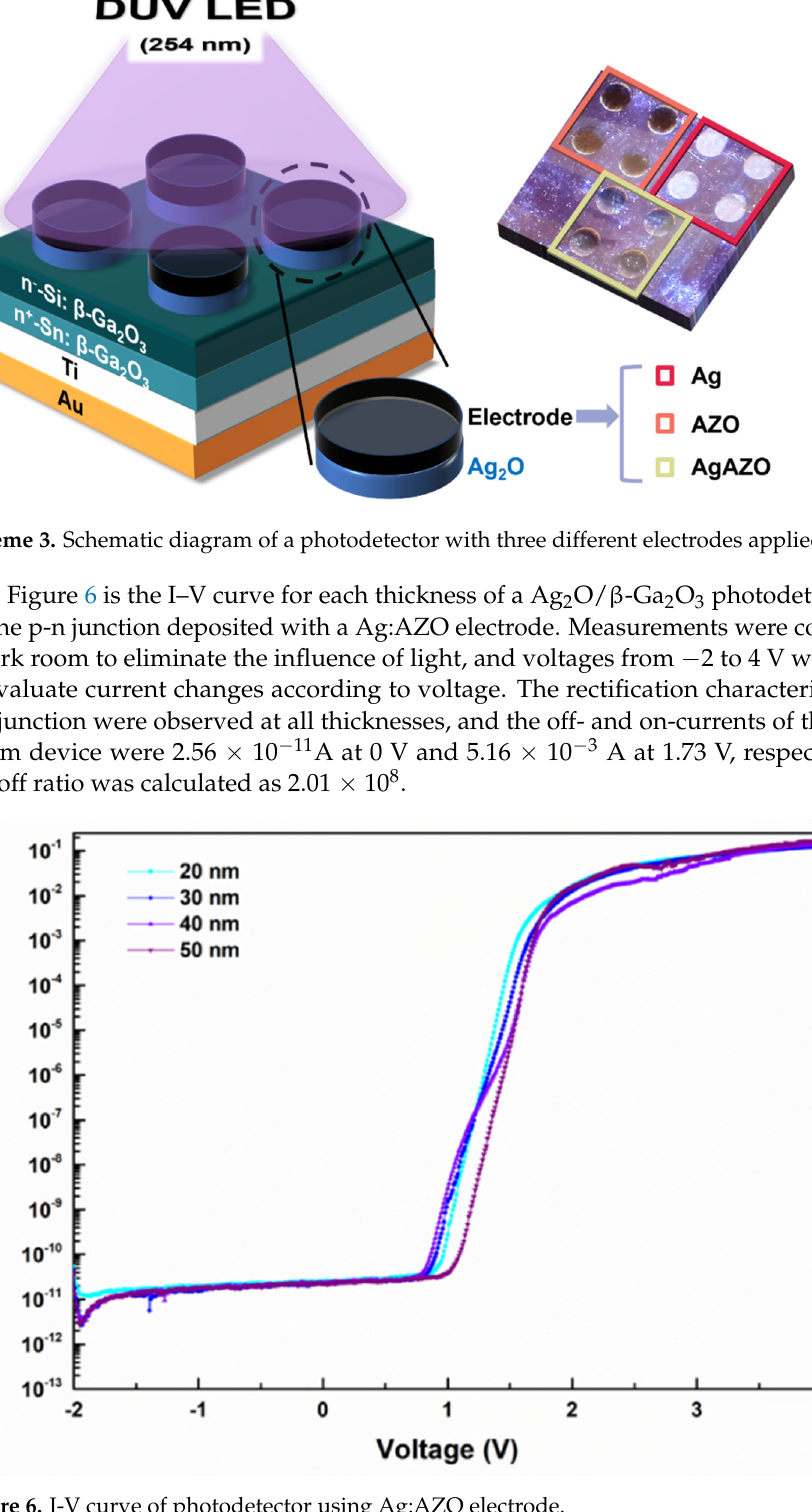
Figure 6. I-V curve of photodetector using Ag:AZO electrode.